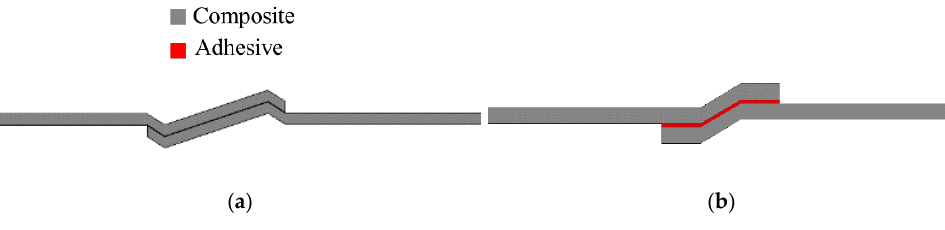
Figure 6. ( a ) Wavy-lap joint and ( b ) flat joggle flat joint (FJF).